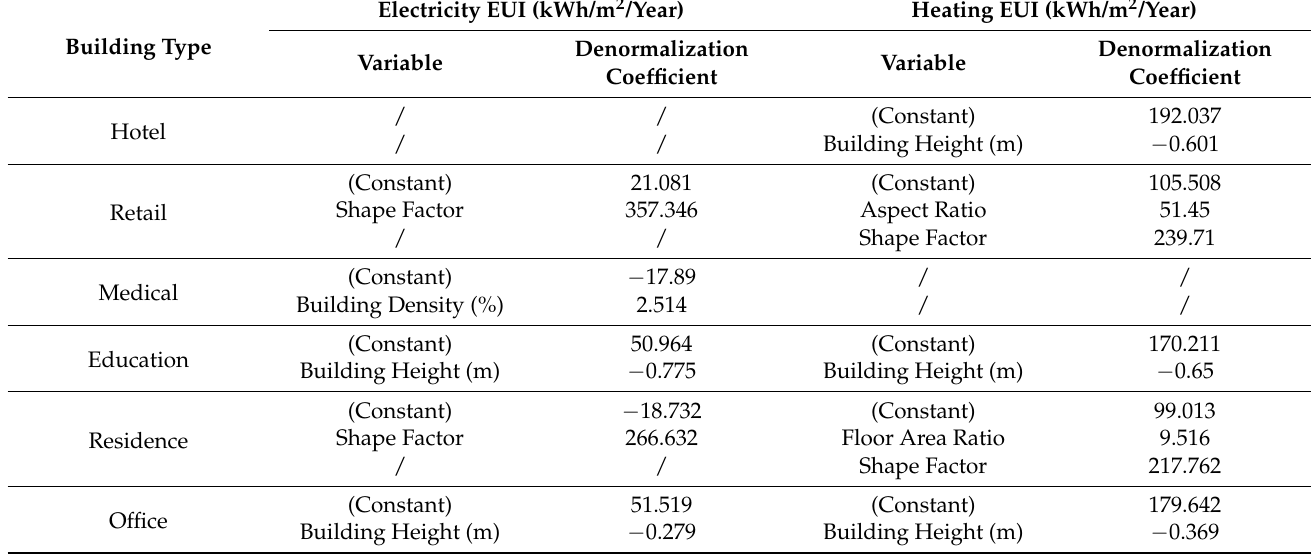
Table 2. Stepwise regression results of urban form factors and building